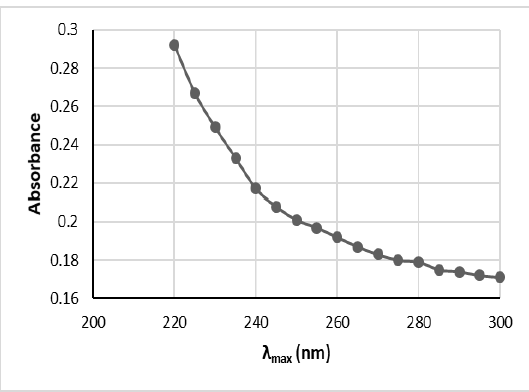
Figure 4. The scanning of roots extract solution. Quercetin calibration curve The concentrations of quercetin and their absorbances are shown in Table (5) . Also, the linearity and the regression equation are shown in Figure (5)